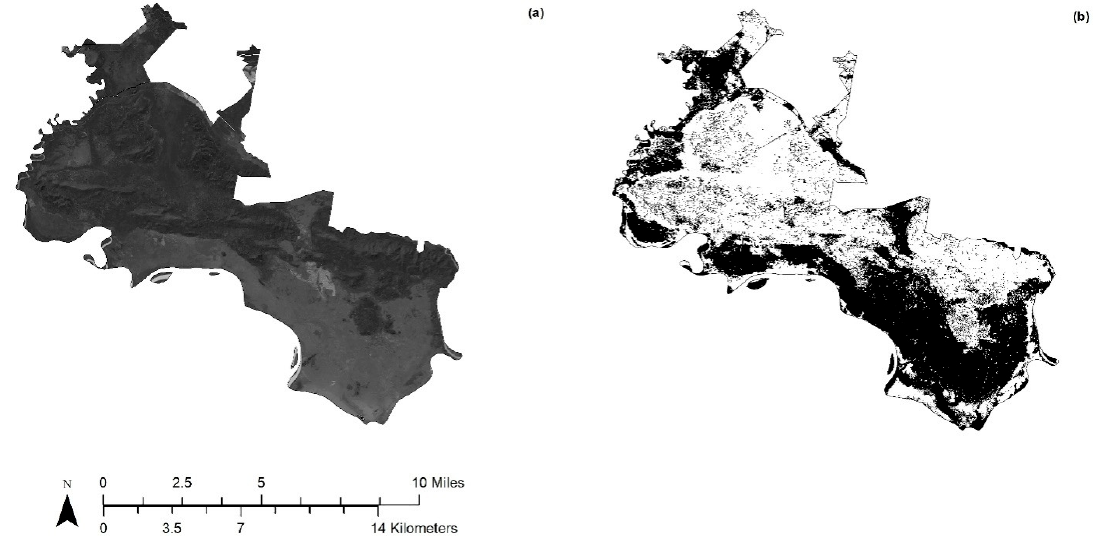
Figure 4. Rule images of Mixture Tuned Matched Filtering (MTMF) scores: ( a ) pre-fire MTMF, ( b ) post fire MTMF.